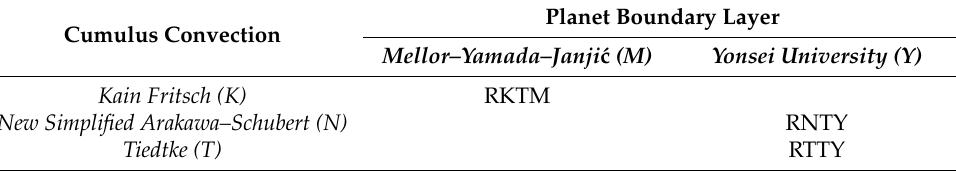
Table 1. The physics combinations of the three members used for the future runs. These members use the same radiation (RRTMG) and microphysics (Thompson) scheme. All simulations are conducted at a 36 km grid